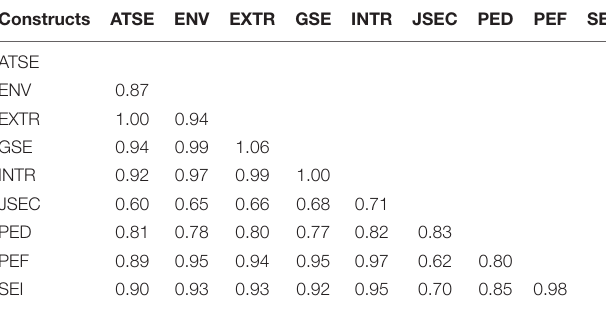
TABLE 6 | Discriminant validity of the total sample (HTMT 0.90